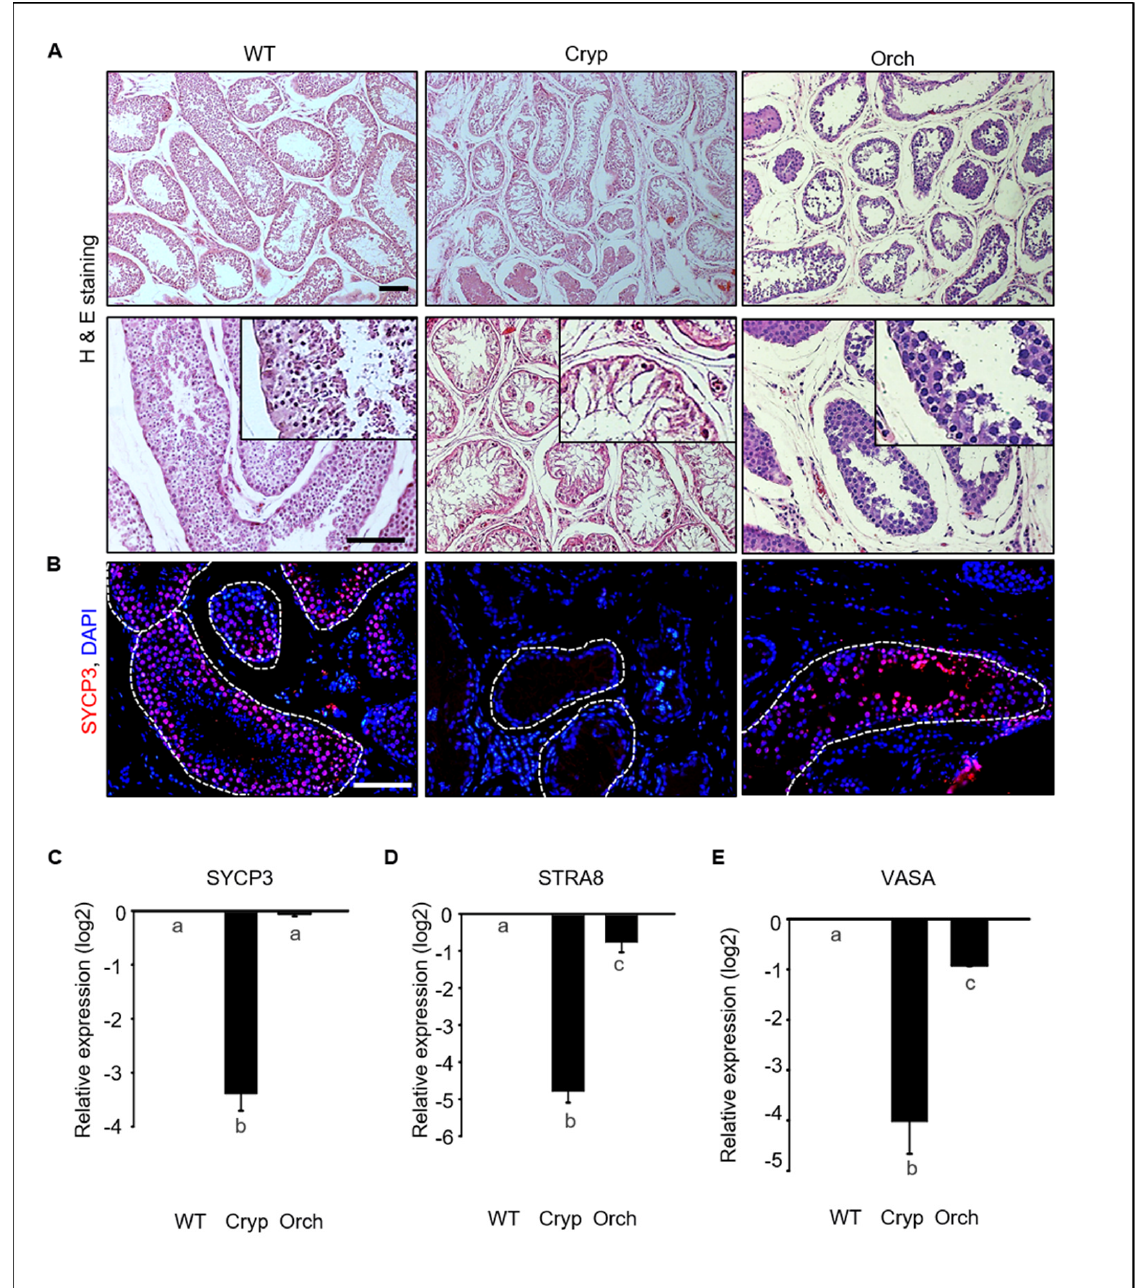
Figure 2. Germ cell depletion in cryptorchid dog testes. ( A ) Morphological changes in wild-type, cryptorchid, and orchiopexy dog testes analyzed using hematoxylin and eosin staining. Many germ cells were depleted in cryptorchid testes compared to wild-type and orchiopexied testes. ( B ) SYCP3, a meiotic marker protein, and DAPI were detected in wild-type, cryptorchid, and orchiopexied canine testes by immunostaining. SYCP3-positive cells were found in both wild-type and orchiopexied dog testes but not in cryptorchid testes. Scale bars = 50 µ m; n = 3, two pairs of testes. ( C – E ) Expressions of SYCP3 , STRA8 , VASA , and GAPDH genes in wild-type, cryptorchid, and orchiopexied dog testes were determined by qPCR. The expression levels of SYCP3 , STRA8 , and VASA genes were decreased in cryptorchid testes compared to the wild-type. Data are presented as means ± standard deviation, and values with different letters are significantly